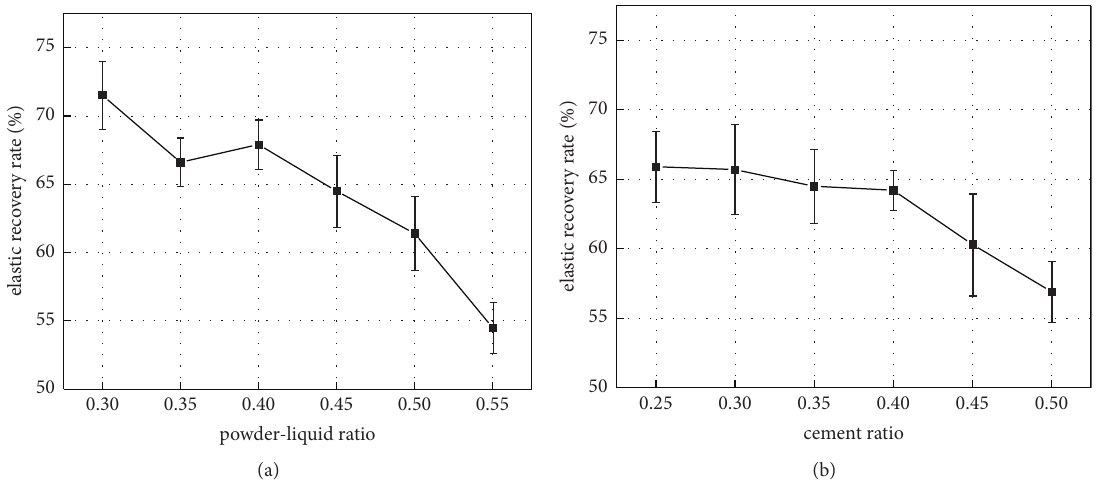
Figure 7: Changes of elastic recovery rate of PCC with powder-liquid ratio and cement ratio: (a) powder-liquid ratio; (b) cement